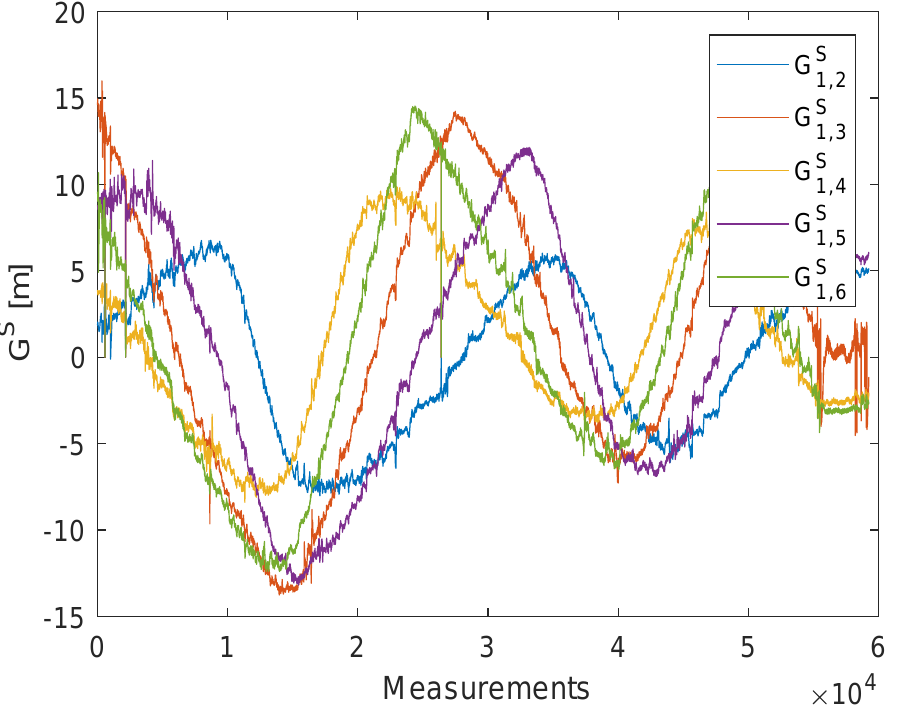
Figure 7. LPM measurement differences. The different colors represent the outcome of the filtered measurements, after every station is subtracted from Station 1. Table 11. Self-calibration results of the real LPM measurements. The identified false optimizations have errors larger than